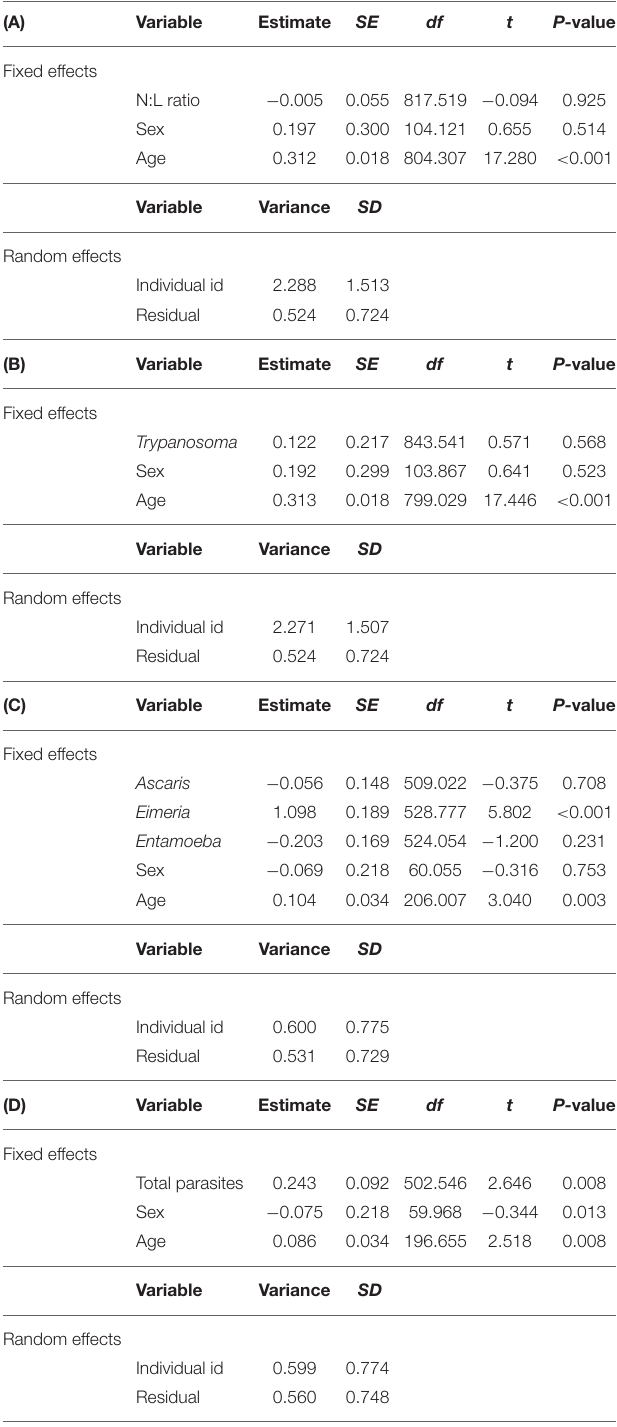
TABLE 1 | Results from linear mixed effects models explaining variation in alarm call entropy as a function of: (A) N:L ratio, (B) the presence or absence of Trypanosoma sp., (C) the presence or absence of each individual intestinal parasite, and (D) intestinal parasite